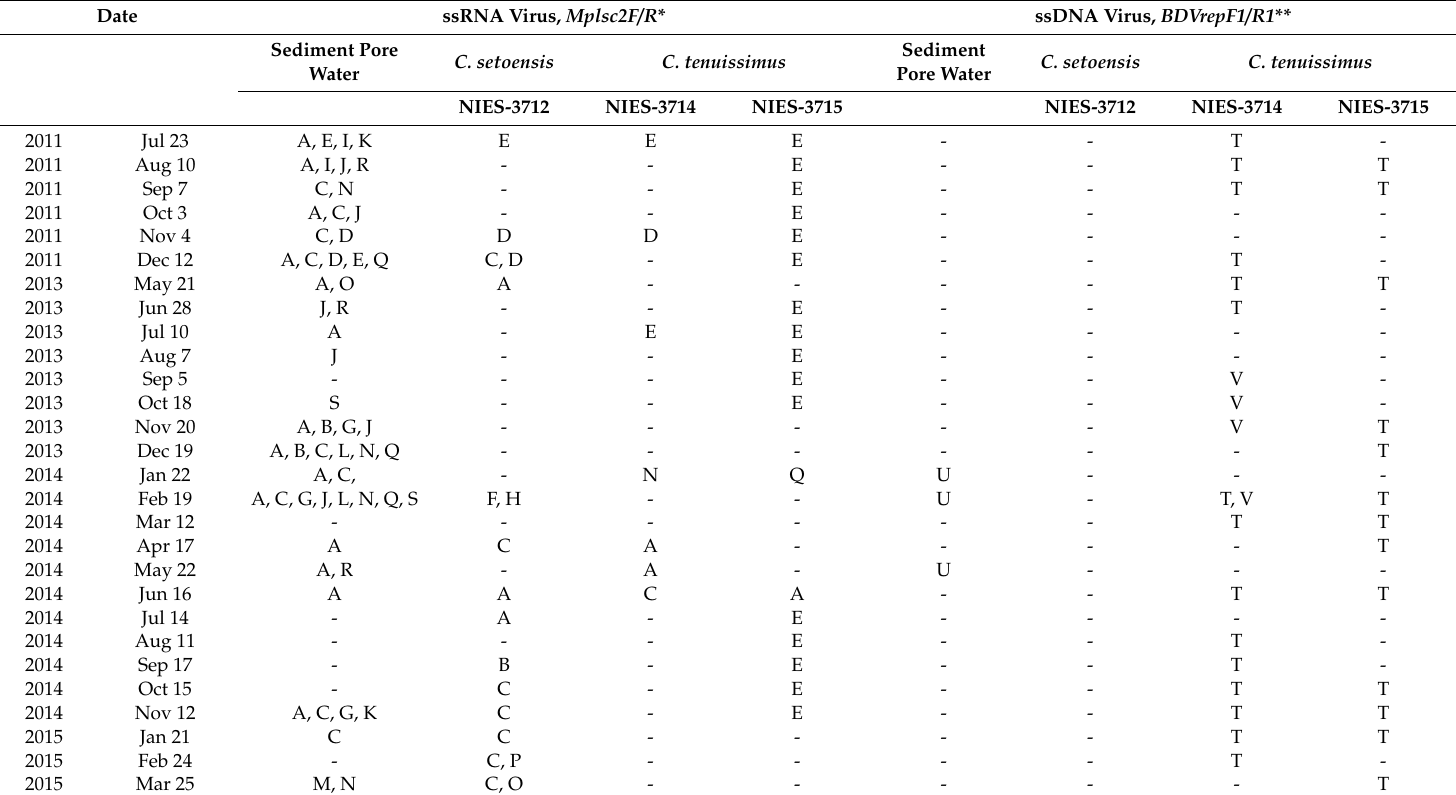
Table 1. Viral RdRp and Rep types detected from sediment pore water in Hiroshima Bay, Japan, using diatom strains Chaetoceros setoensis and Chaetoceros tenuissimus during the study period. RdRp (A–S) and Rep (T–V) types were determined based on the phylogenetic trees in Figures 1 and 2, respectively. Mplsc2F / R * and BDVrepF1 / R1 ** are primer pairs used for the amplification of the RdRp and Rep regions, respectively. ‘-‘ indicates not